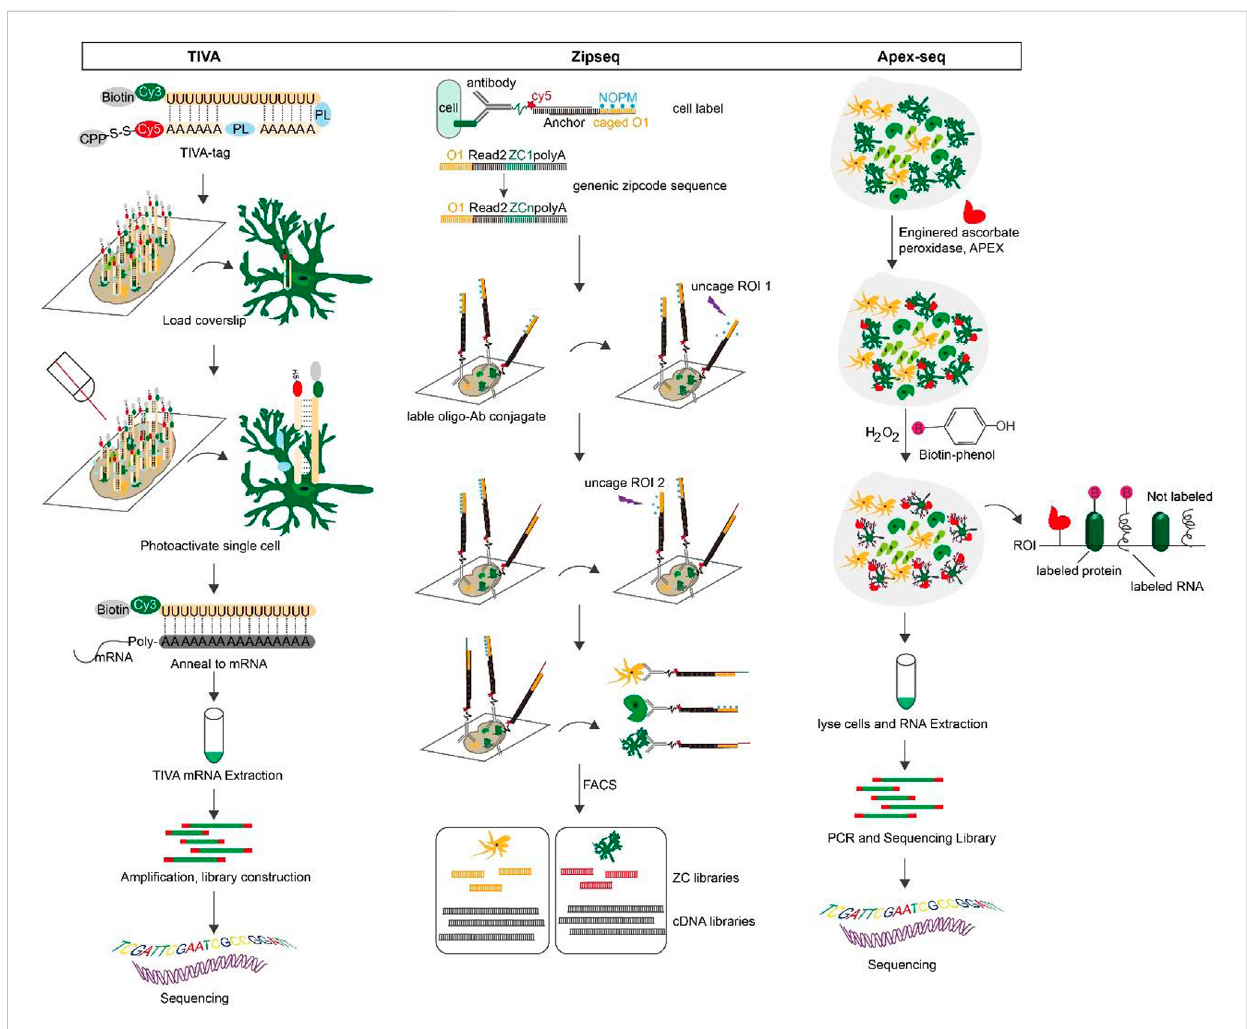
FIGURE 5 The overview and principle of space transcriptome technology based on living cell